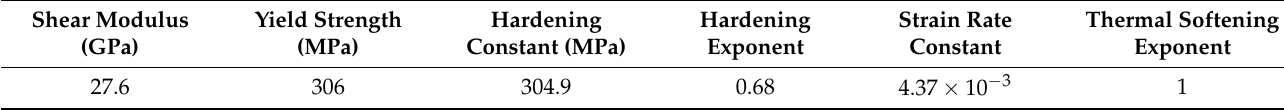
Table 2. Properties of aluminium alloy AA6082-T6 used in the